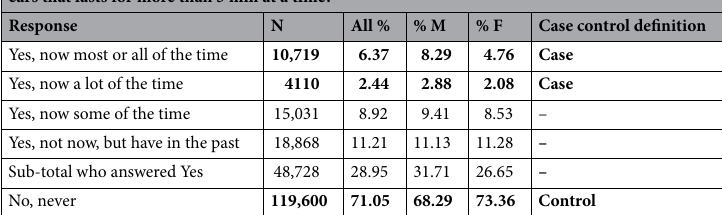
Table 1. Prevalence of tinnitus in UK Biobank participants. Percentage values correspond to the proportion of participants that selected one of these five responses (N = 168,328 participants). An additional 4280 participants selected either “Do not know” or “Prefer not to answer”. %M and %F is the percentage answers for males and females respectively. Case Control Definition designates if the participants who gave these responses were included in the GWAS as Cases or Controls. Entries for those included in the GWAS are shown in bold.